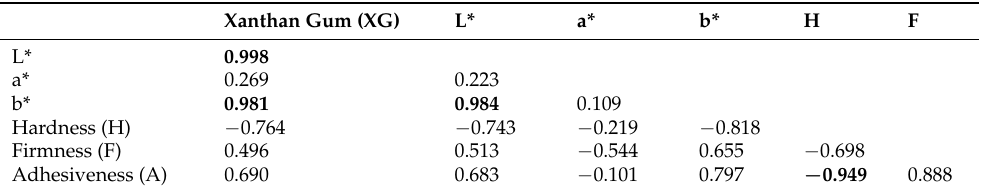
Table 5. Correlations between parameters measured for walnut butter samples with maple syrup and xanthan gum (Pearson correlation).